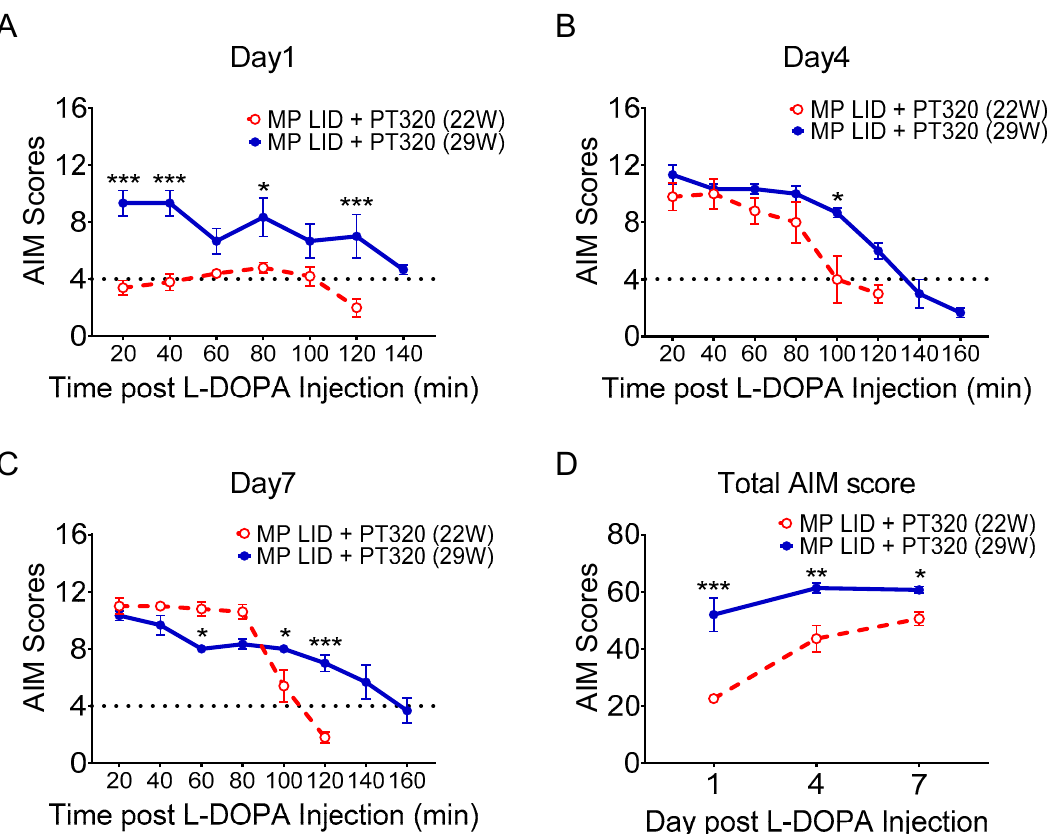
Figure 8. AIM scores comparing the early PT320 treatment (treatment begun at 5 weeks old and AIM recorded at 22 weeks old) and late PT320 treatment groups (treatment begun at 17 weeks old and AIM recorded at 29 weeks old). ( A ) AIM scores in the late treatment group were higher than in the early treatment group at almost all recording time points. ( B ) AIM scores were higher in the late treatment group at the middle and late recording time points on Day 4. ( C ) The duration of abnormal dyskinesia was longer in the late treatment group. ( D ) Total AIM scores were higher in the late treatment group from day 1 to day 7 of the induction protocol than scores in the early treatment group during a similar period. Two-way analysis of variance (ANOVA) followed by Bonferroni post hoc test for multiple comparisons. * p < 0.05, ** p < 0.01, *** p < 0.001 compared with MP LID + PT320 (22W).